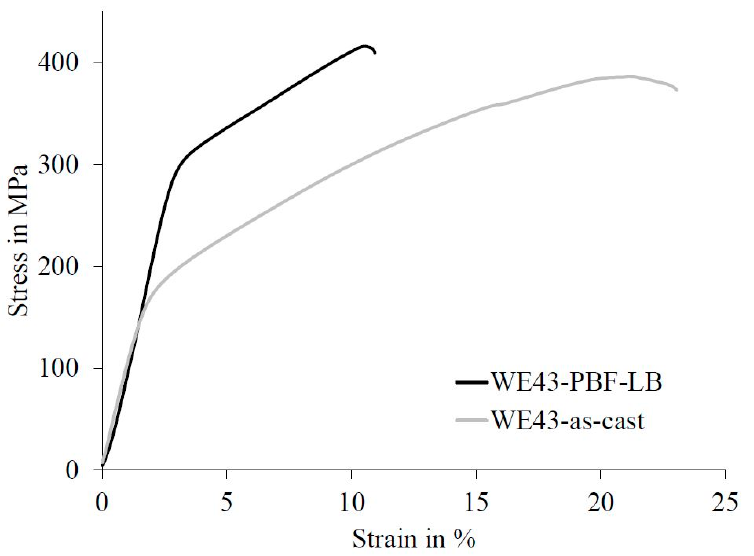
Figure 11. Stress–strain diagram of as-cast and PBF-LB-generated WE43 under compressive load.